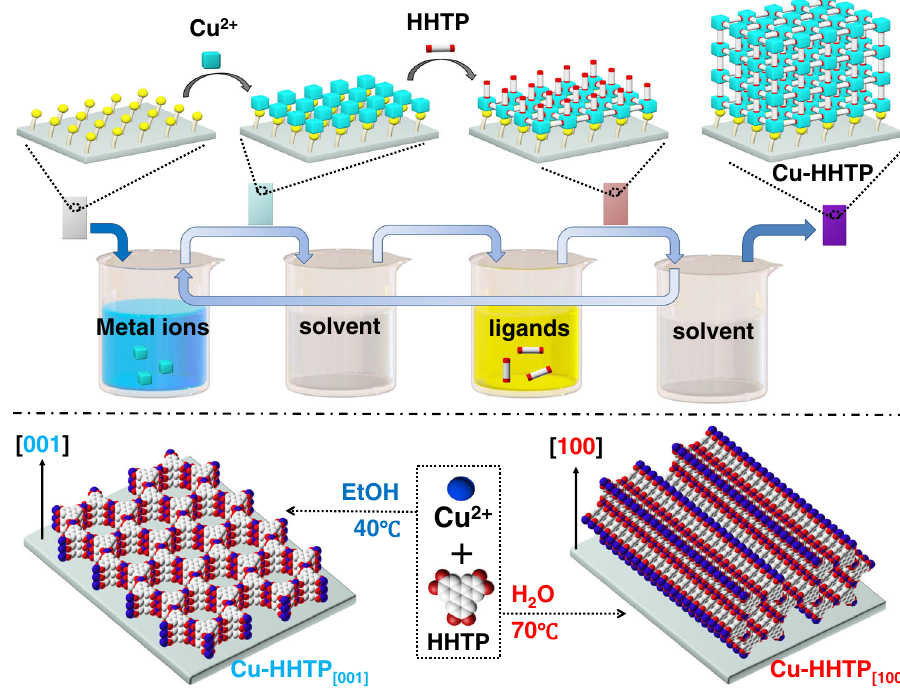
Fig. 1 | Preparation of Cu-HHTP fi lms. The preparation process of Cu-HHTP fi lms with [001]- and [100]-orientations by LPE LBL